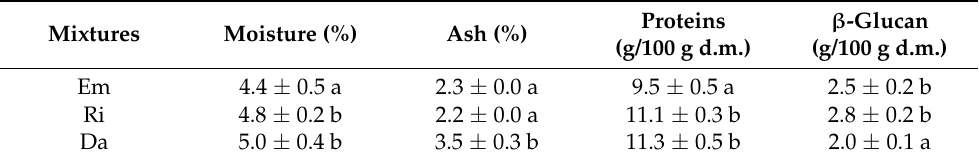
Table 1. Composition of the 3 binary mixtures made of 60% barley malt and 40% unmalted cereals (alternatively durum wheat cv. Dauno III. Soft wheat cv. Risciola, or dehulled emmer).